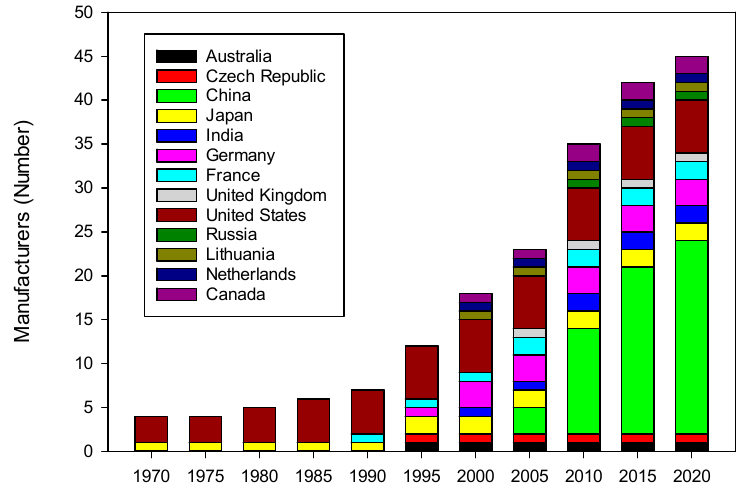
Figure 3. Evolution of the number of electrodialytic system manufacturers around the World from 1970 to 2020.